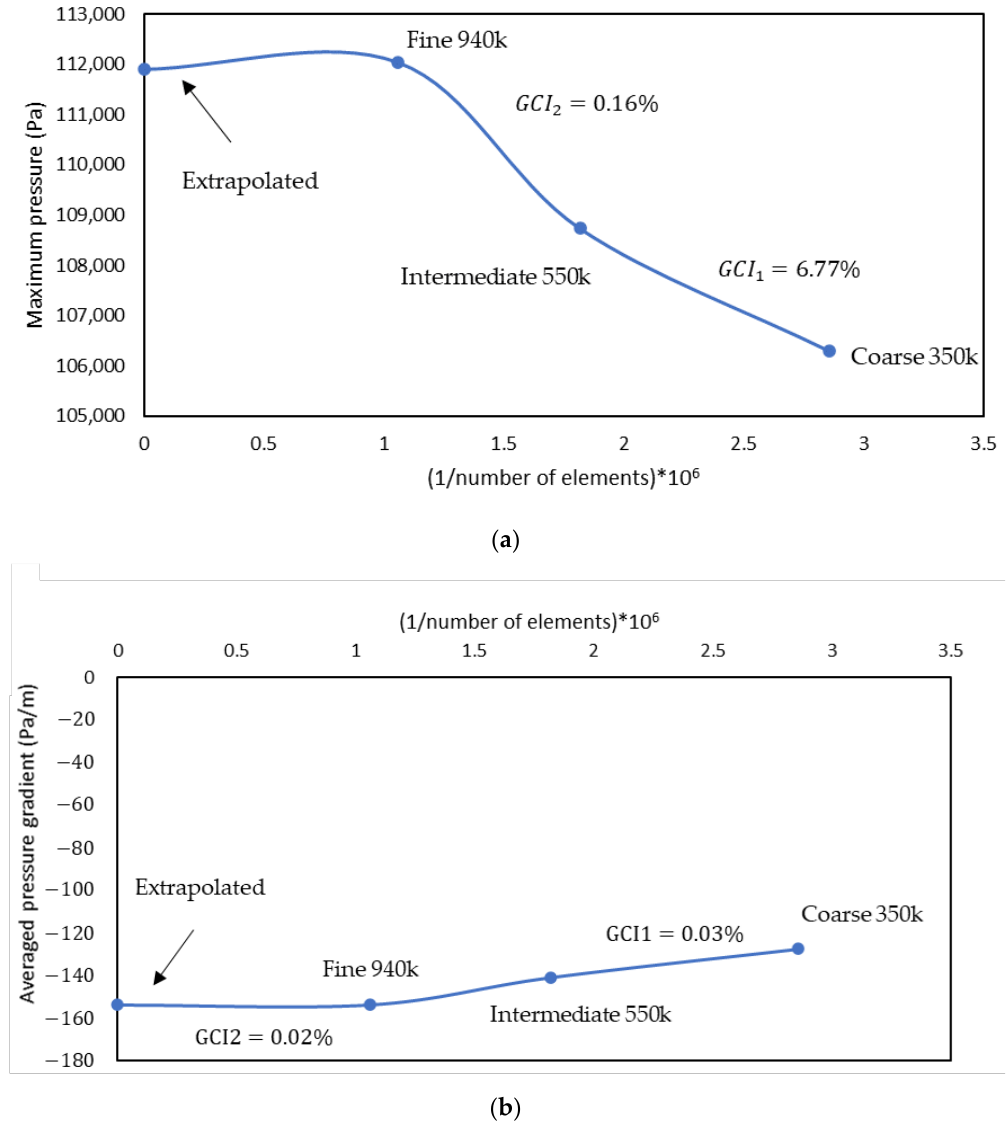
Figure 3. Mesh independency study: ( a ) Maximum pressure, and ( b ) averaged pressure gradient against 1/number of